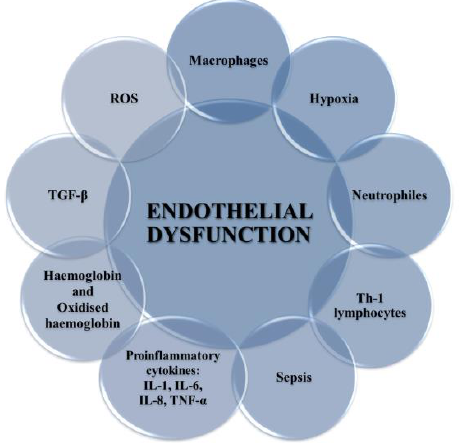
Figure 4. Factors leading to the development of endothelium dysfunction. These include ROS, proinflammatory cytokines (IL-1, IL-6, IF-8, TNF- α ), TGF- β , Hb and oxyHb, Th-1 lymphocytes, sepsis, macrophages, and neutrophils.